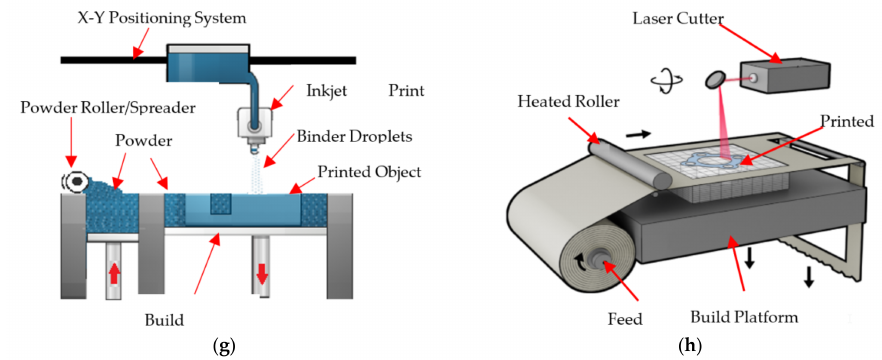
Figure 3. Metal AM Processes; ( a ) VAT Photopolymerisation System [41], ( b ) Material Extrusion Process, ( c ) Power Bed Fusion Process, ( d ) Wire DED Process [40], ( e ) Powder DED Process [42], ( f ) Material Jetting Process, ( g ) Binder Jetting Process, and ( h ) Sheet Lamination Process